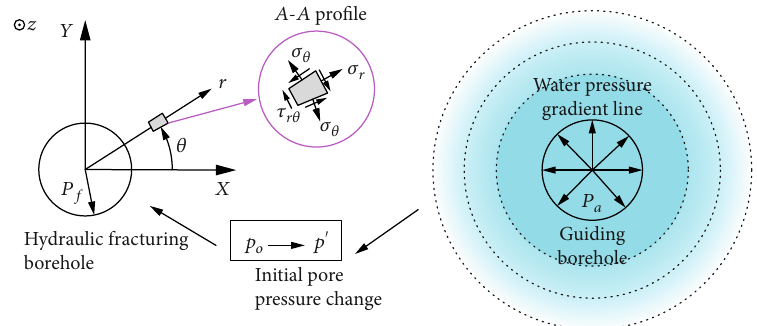
Figure 3: The formation of nonuniform pore pressure fi eld and its in fl uence on fracturing borehole stress.